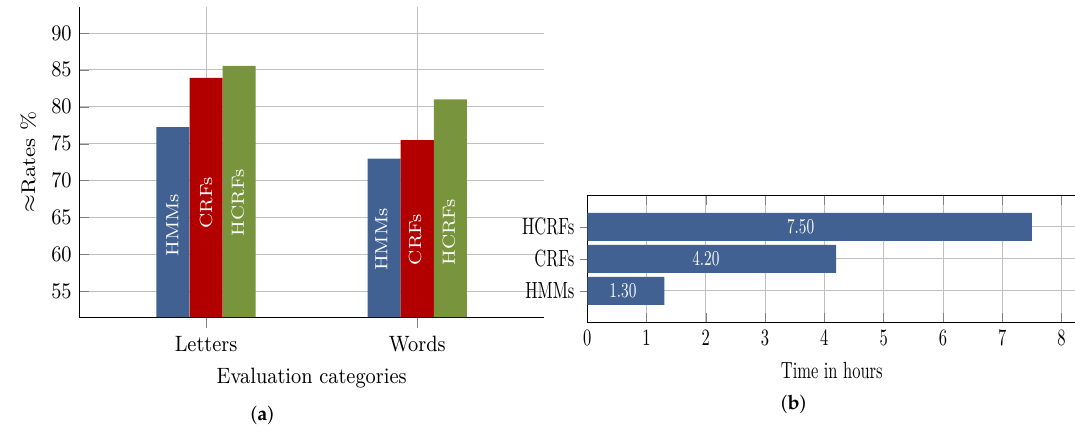
Figure 11. Overall recognition performance and training costs in terms of time: ( a ) the average performance of the three approaches for the recognition of segmented letters and for recognized words with confidence values greater than 0.5; ( b ) the average time needed to model letters of one